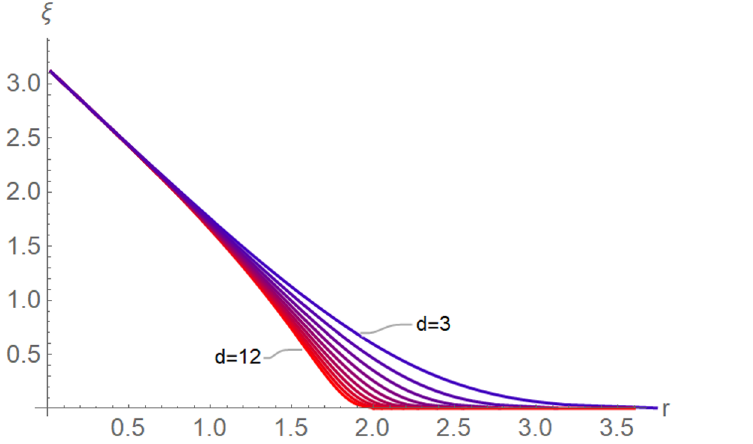
Figure 3 . Numerical solutions for equation (3.19) with pion-mass type potential to the power of s = d